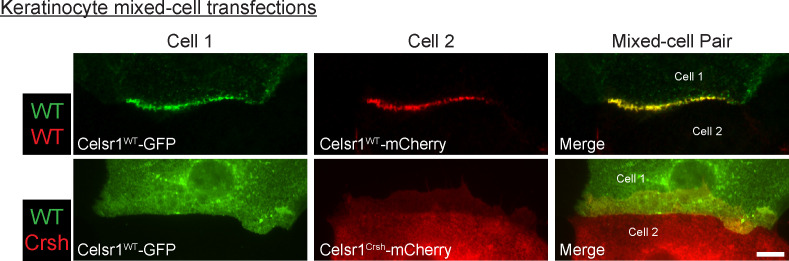
Celsr1Crsh does not form stable trans-interactions with Celsr1WT in keratinocytes.Cultured mouse keratinocytes transfected with Celsr1WT-GFP were mixed with keratinocytes transfected with mCherry-tagged variants of either Celsr1WT (WT-WT mixed border) or Celsr1Crsh (WT-Crsh mixed border). Cells were switched to 1.5 mM calcium for 24 hr. Images are cropped and rotated to display cell border with horizontal orientation. Celsr1WT-GFP is displayed as the top cell in each cell pair, whereas mCherry-tagged Celsr1 variants are displayed as the bottom cell of each pair. Scale bar, 10 µm. See Figure 7—figure supplement 1C for additional Celsr1WT/Celsr1Crsh mixed-cell border examples.